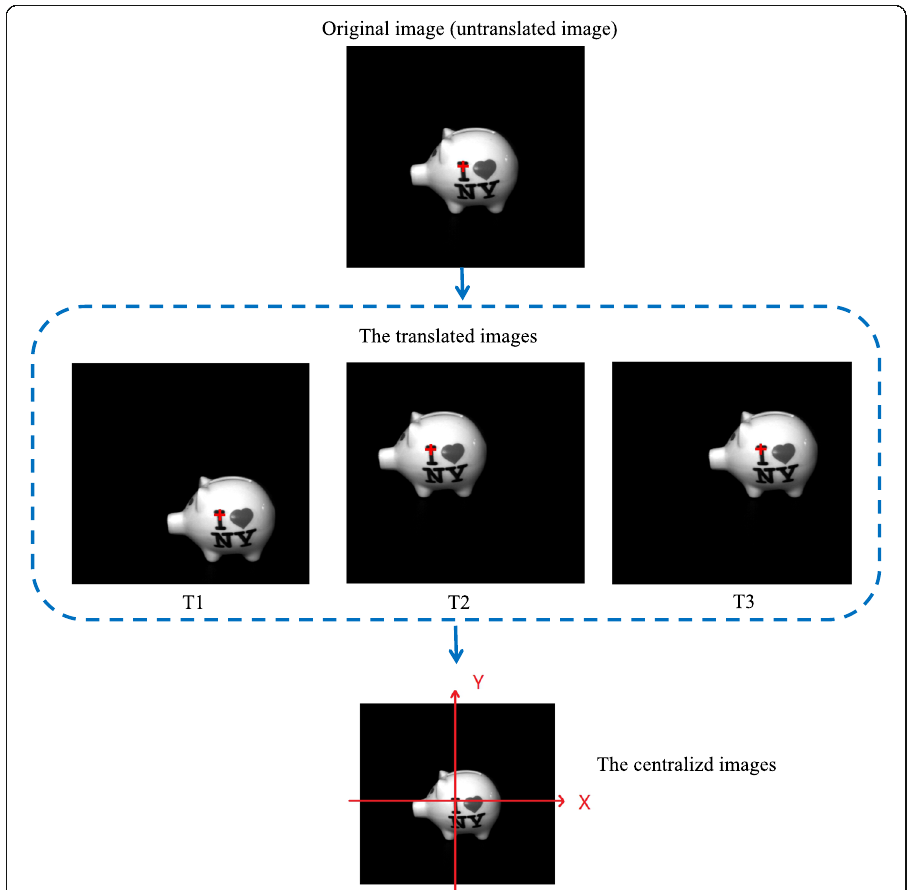
Fig. 3 The processing of translation